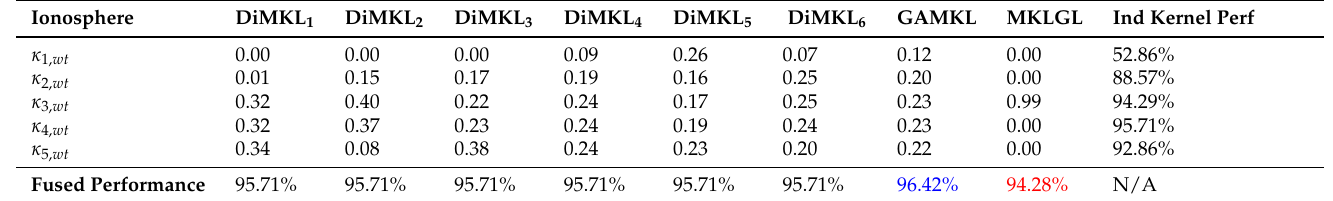
Table 8. Ionosphere: highest performing method is shown in blue; lowest performing is shown in red.